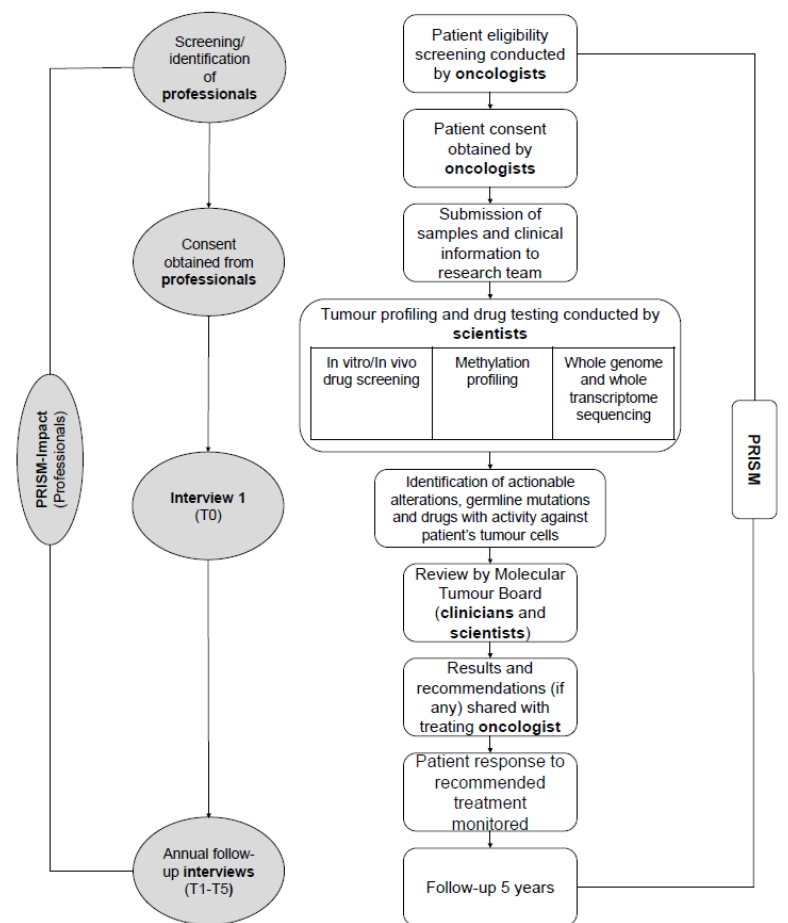
Figure 1. PRISM and PRISM ‐ IMPACT (professionals) study flowchart identifying study procedures and roles.